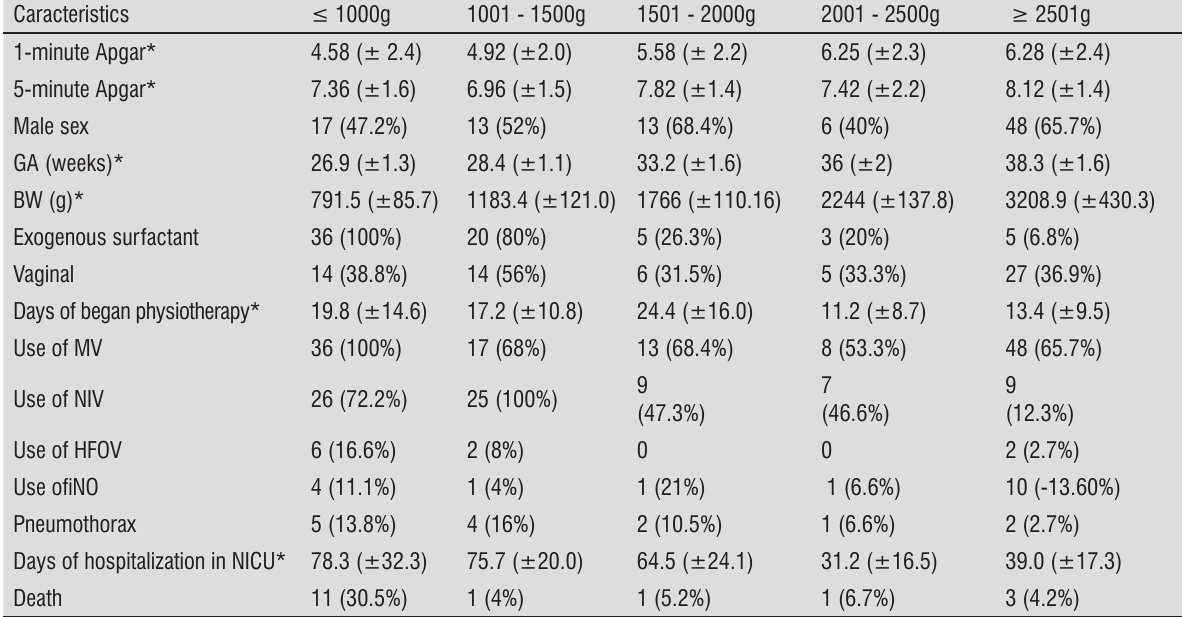
Table 2 - Characterization of the sample according to birth weight (g) Caracteristics ≤ 1000g